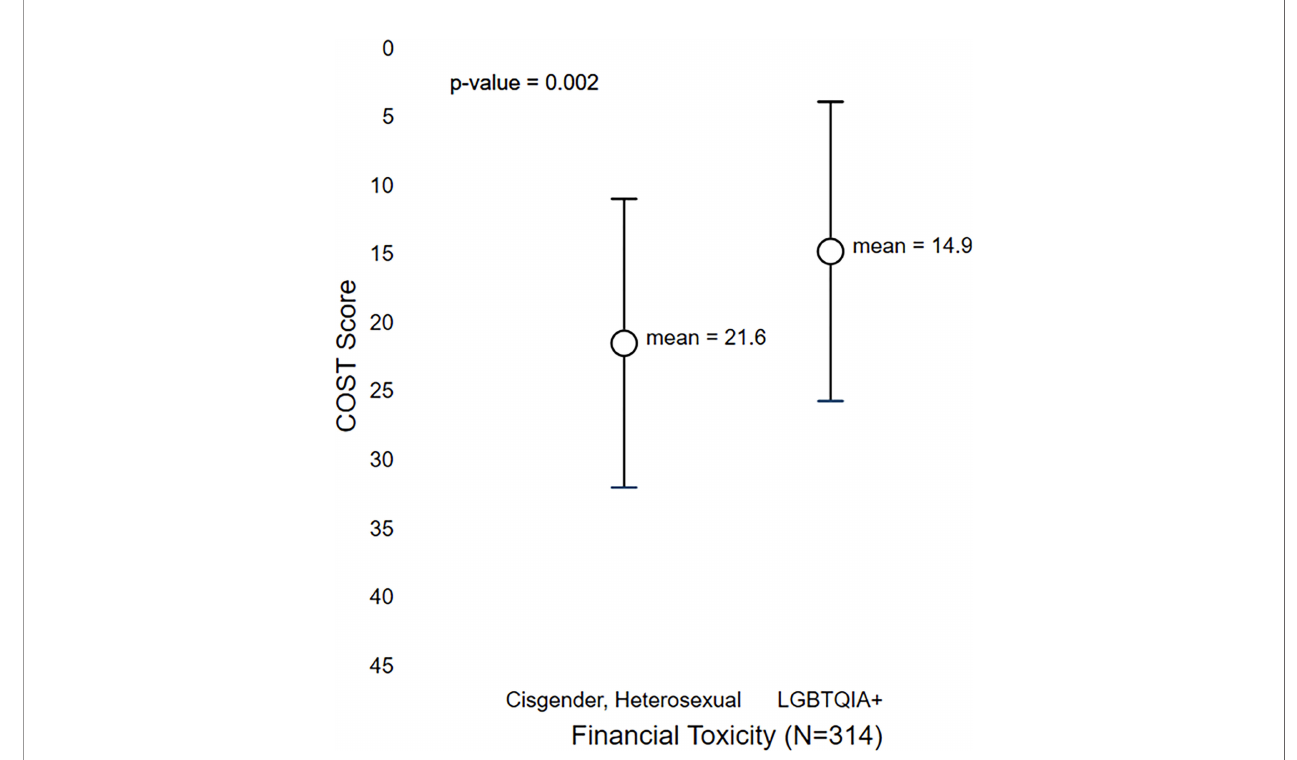
FIGURE 3 | Differences in COST Scores Between Cisgender, Heterosexual and LGBTQIA+ AYA Cancer